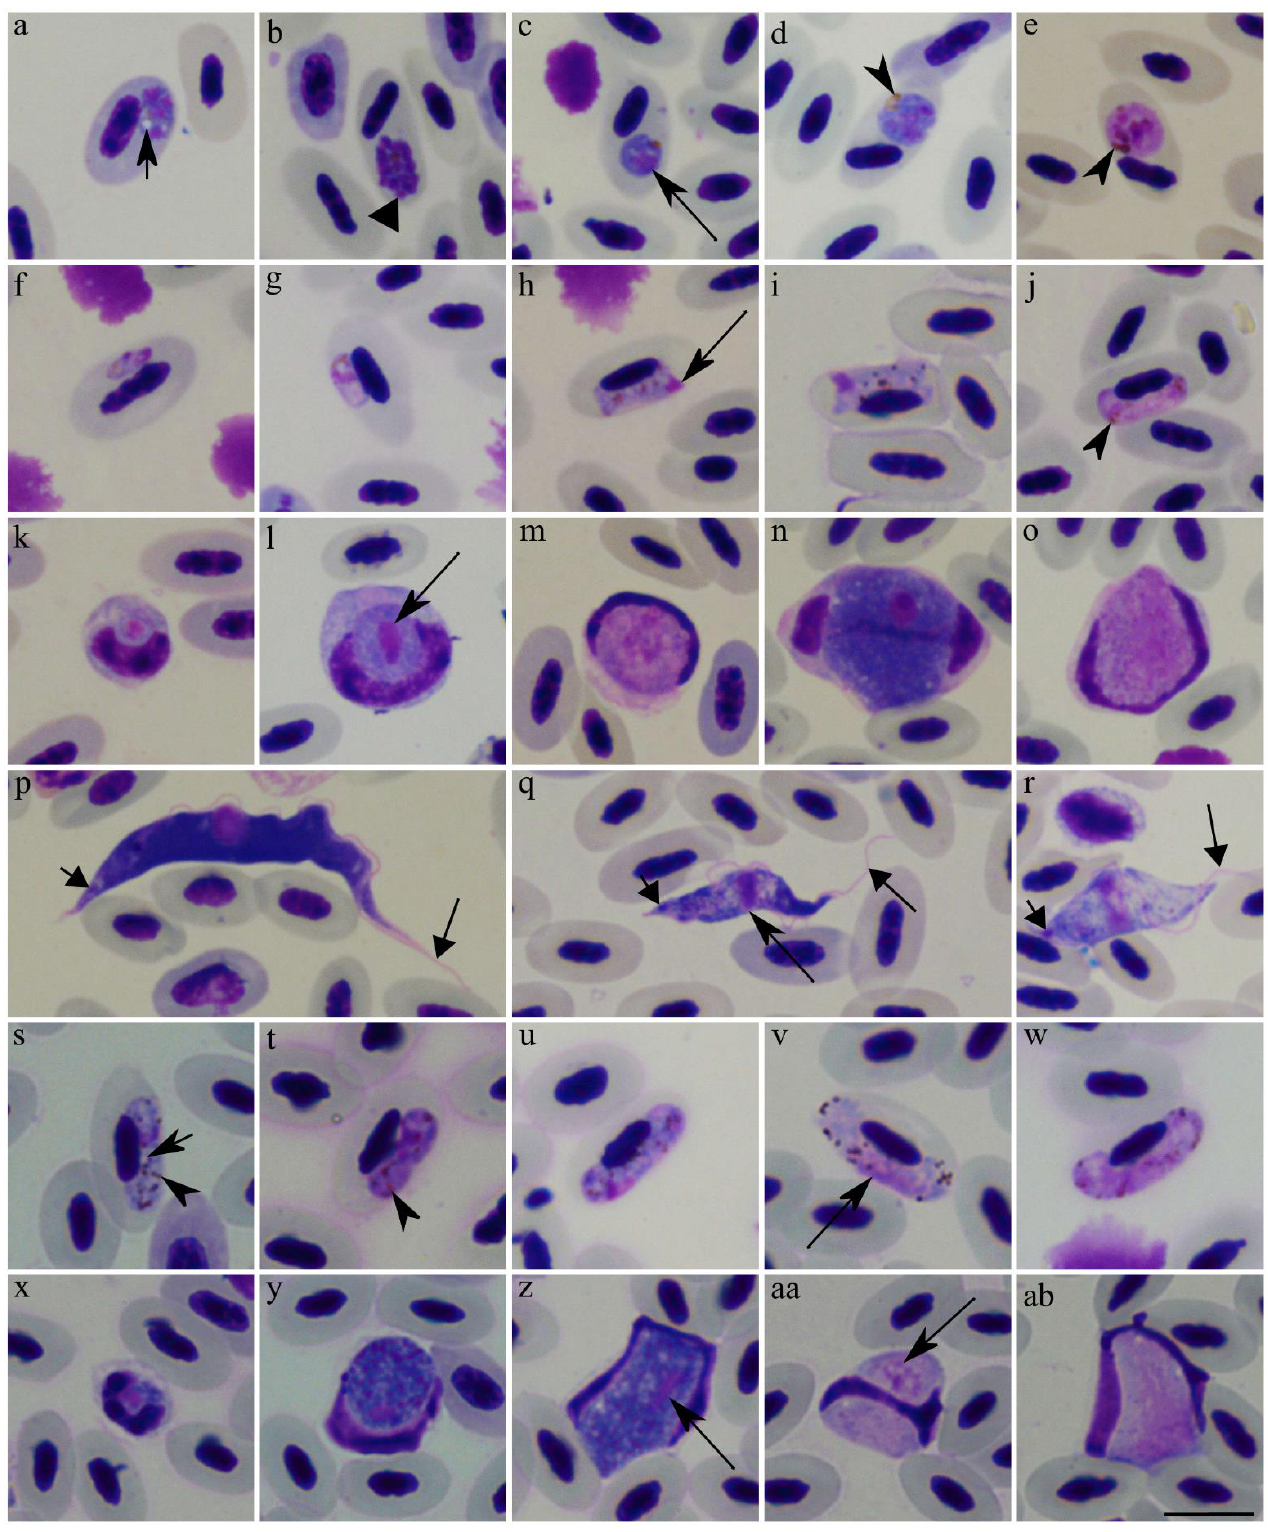
Figure 1. Blood parasites that were found in a Eurasian blackbird ( Turdus merula ) ( a – r ) and a Song thrush ( Turdus philomelos ) ( s – ab ). Plasmodium matutinum (cytochrome b lineage pLINN1): growing ( a ) and mature ( b ) meronts, growing ( c ) and mature ( d ) macrogametocytes, and microgametocyte ( e ). Haemoproteus minutus (hTURDUS2): young gametocytes ( f , g ), growing macrogametocyte ( h ), mature macrogametocyte ( i ) and microgametocyte ( j ). Leucocytozoon sp. (unknown lineage): young ( k ) and growing ( l , m ) gametocytes, mature macrogametocyte ( n ) and microgametocyte ( o ). Trypanosoma avium ( p ) and Trypanosoma everetti ( q , r ) group parasites. Haemoproteus homominutus (unknown lineage): growing gameto-